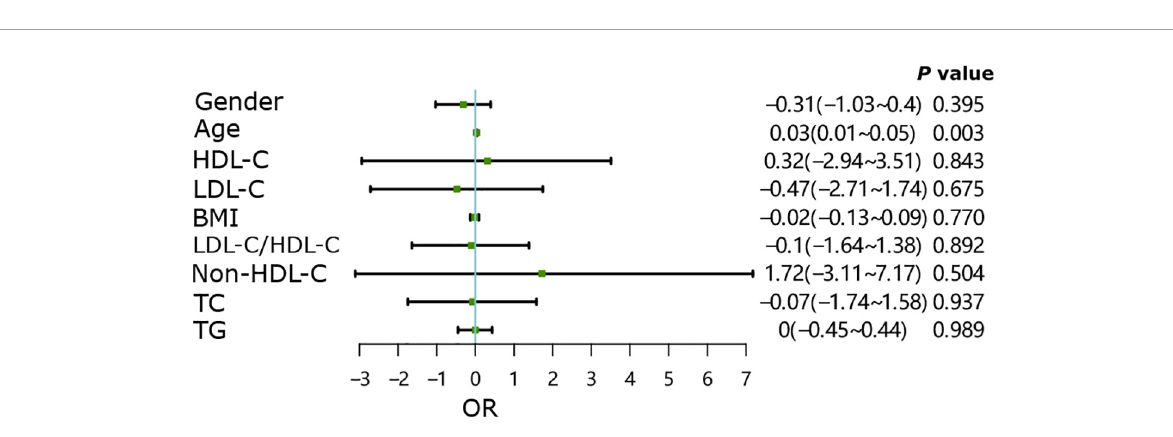
FIGURE6 Contributing factors and endplate inflammation in patients without underlying